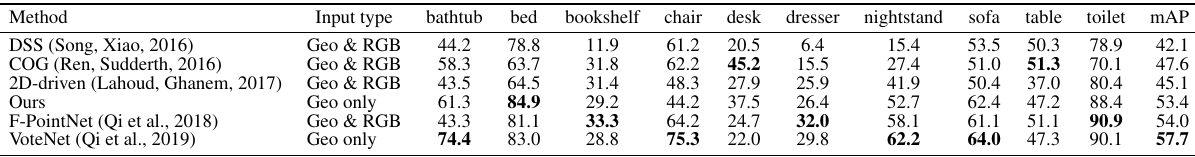
Table 4. Results of 3D object detection on the SUN RGB-D validation set Scene RGB Predictions